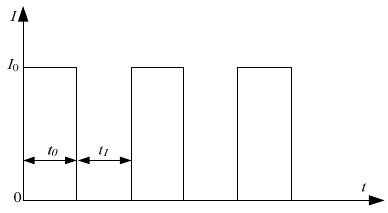
Figure 2. Schematic diagram of pulse current waveform.